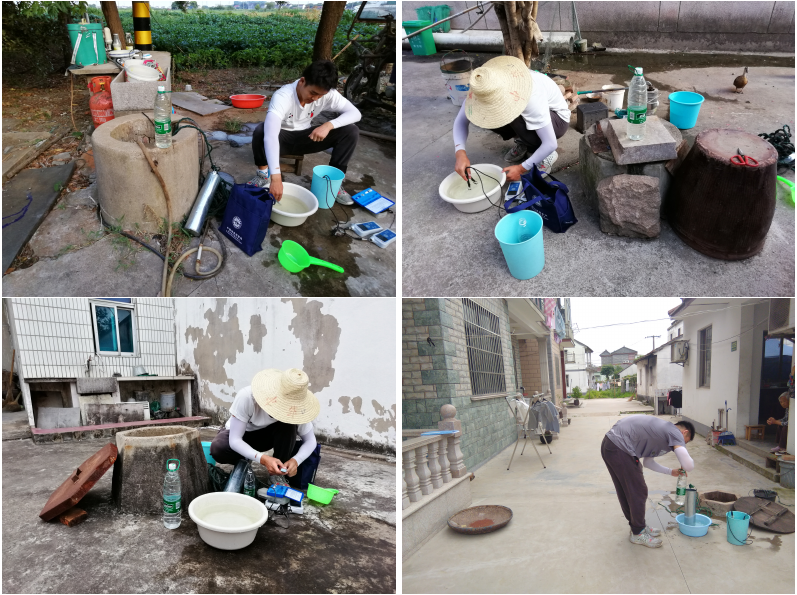
Figure 3. The landscape surroundings of several wells and the in situ test procedures. Table 1. Water quality parameters, units and analytical methods used for groundwater samples in the pilot promoter region of Yangtze River Delta integration demonstration